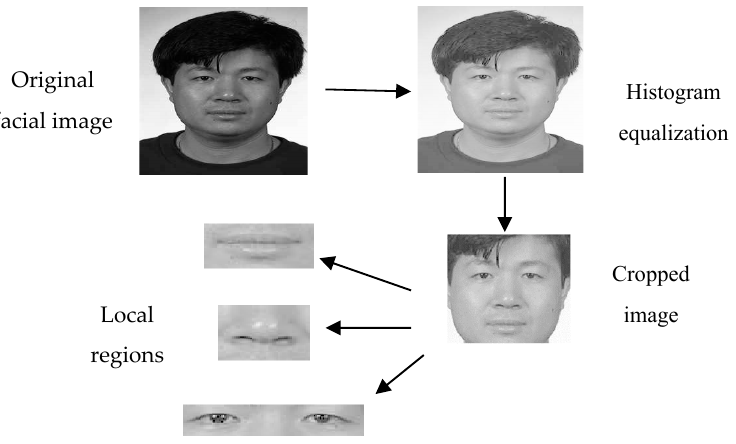
Figure 2. Face detection and preprocessing.